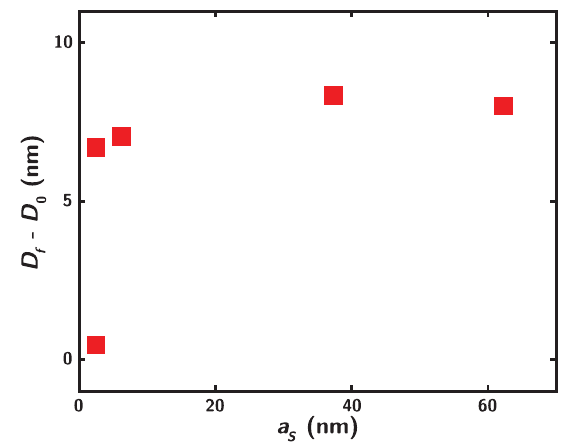
FIG. 7. Comparison of the hydrodynamic zero D 0 and the position of the frictional response D f as a function of the applied shear oscillation amplitude a S for insulating confinement